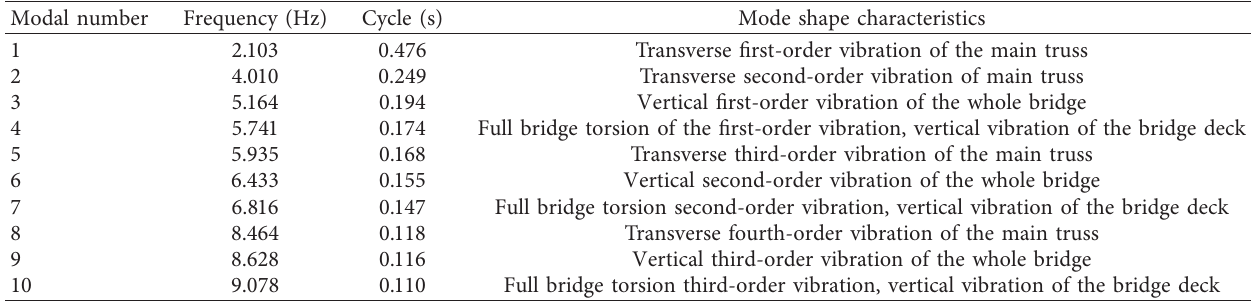
Table 2: The first 10-order natural vibration characteristics of the bridge after reinforcement.